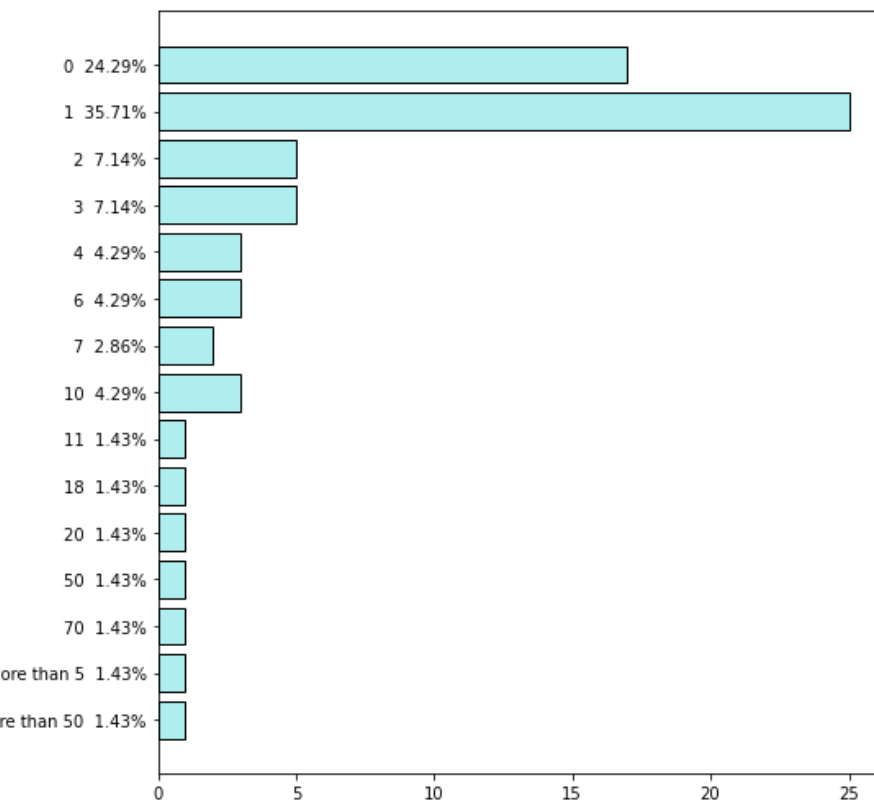
Figure 7. Number of production sites